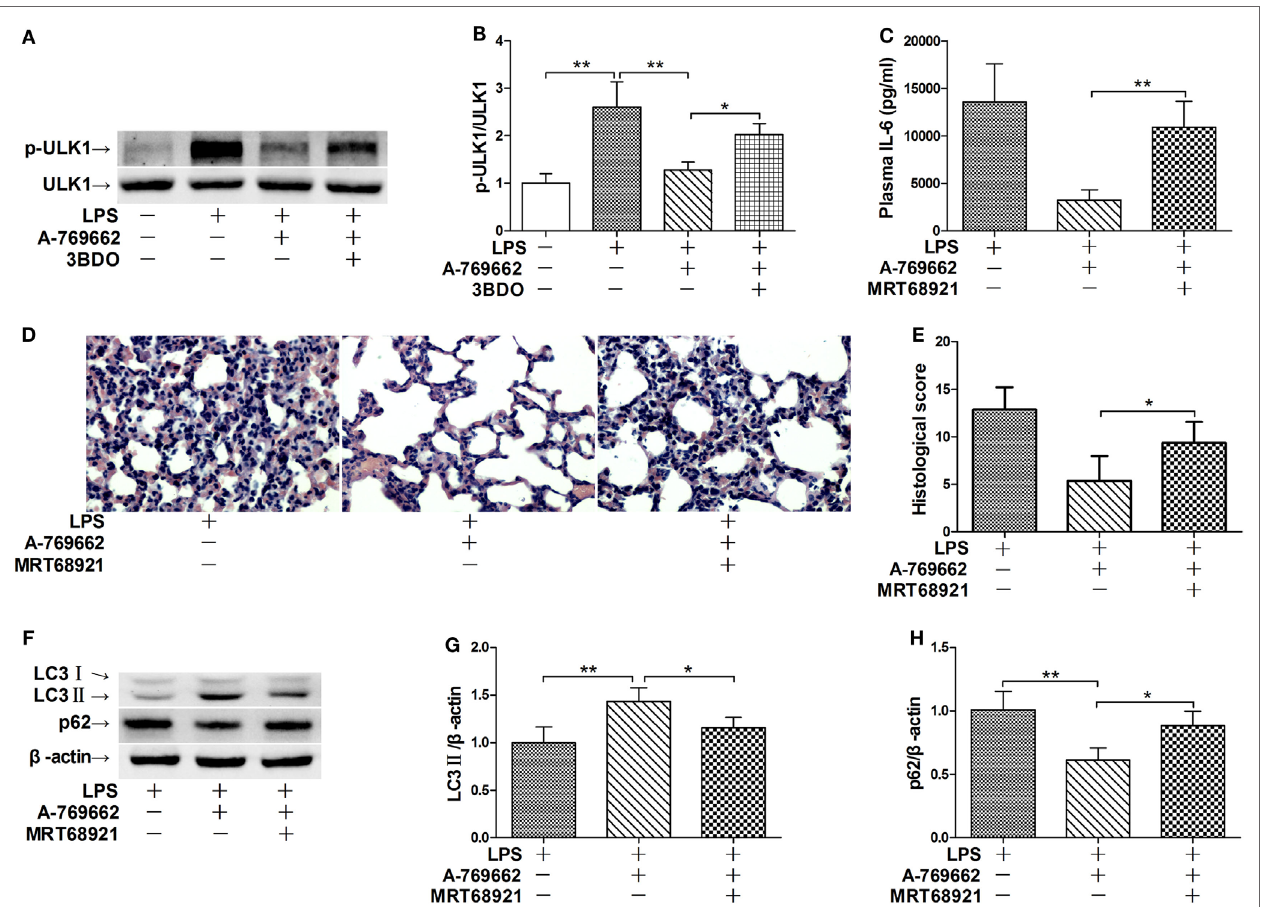
FigUre 5 | Inhibition of ULK1 reversed the suppressive effects of AMP-activated protein kinase (AMPK) activator on inflammatory injury and autophgay. (a,B) Mice were exposed to lipopolysaccharide (LPS) (20 mg/kg) with vehicle, AMPK activator A-769662, and mammalian target of rapamycin activator 3BDO administration. The level of phosphorylated ULK1 (p-ULK1) and total ULK 1 (ULK 1) was determined by immunoblot (a) , and the blots were semi-quantified (B) ( n = 4). (c–g) Mice were exposed to LPS (20 mg/kg) with vehicle, AMPK activator A-769662, and ULK1 inhibitor MRT68921 administration. The plasma level of interleukin 6 (IL-6) was determined by enzyme-linked immunosorbent assay (c) ( n = 8). The histological abnormalities of the lung tissue were observed with hematoxylin & eosin staining. The representative lung sections of each group were shown (D) , the histopathological alterations were blindly scored (e) . The level of LC3II and p62 was determined by immunoblot (F) , and the blots were semi-quantified (g,h) ( n =